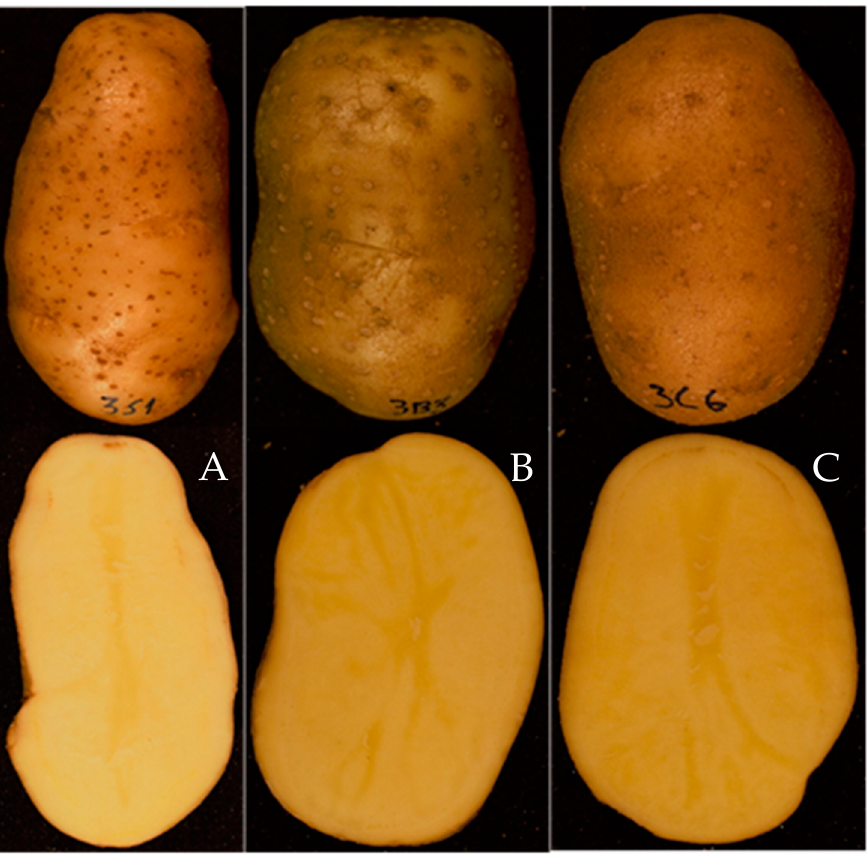
Figure 1. Images from the skin and the flesh of representative tubers from three commercial potato cultivars: Spunta ( A ), Banba ( B ), and Sylvana ( C ). 2.2. Color